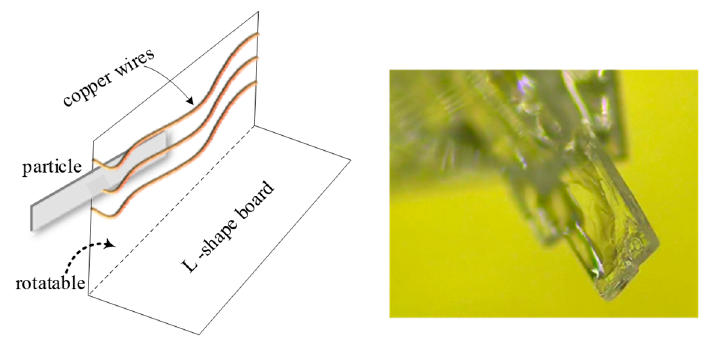
Figure 5. The equipment to measure thickness of the